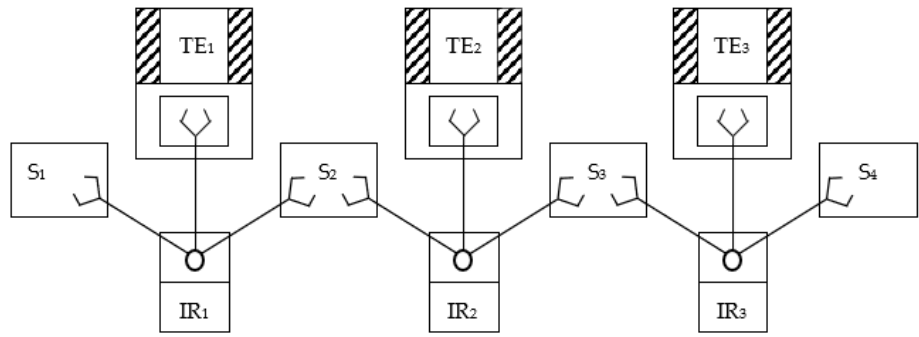
Figure 1. Scheme of a single-stream robotic cold stamping technological line.